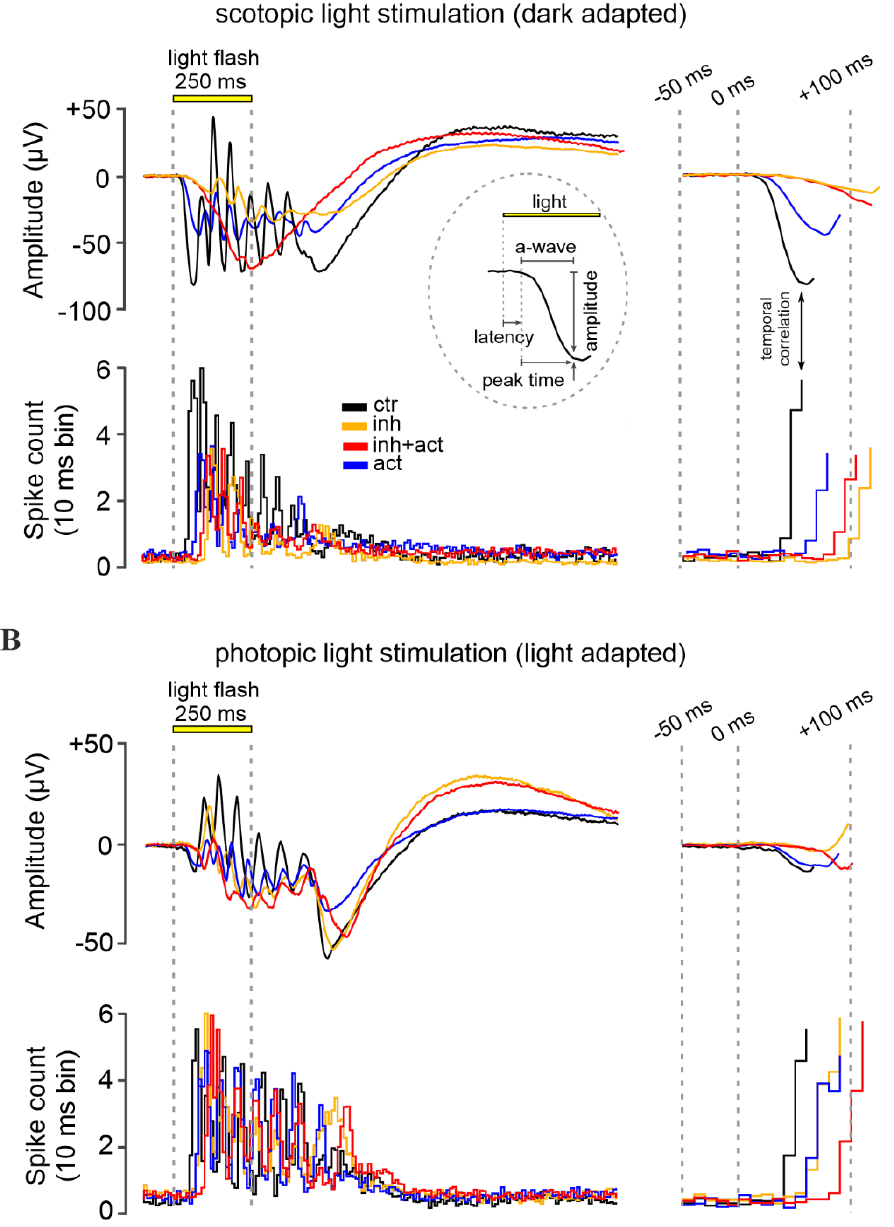
Figure 5. Effects of cGMP analogues on retinal function. Representative light-evoked dark-adapted scotopic (rod) ( A ) and light-adapted photopic (cone) ( B ) micro-electroretinogram ( µ ERG) of the mouse retina. Control recording (black) was compared to retina treated with the CNG-channel inhibitor Rp-8-Br-PET-cGMPS (50 µ M, orange), the CNG-channel activator 8-pCPT-cGMP (0.1 µ M, blue), or both compounds in combination (red). Displayed below the µ ERG traces is the correlated retinal ganglion cell spiking activity recorded by multi-electrode arrays (MEA). Data shown at maximum scotopic and photopic light intensity, respectively (see Figures S3 and S4 for µ ERG recordings at all light intensities). The left panel illustrates the recorded signals, while the right panel highlights the initial light-response features, magnified in time. The initial negative deflection of the µ ERG, the a-wave, represents the hyperpolarizing photoreceptor response. Subsequent oscillations reflect responses of inner retinal cells. The inset in ( A ) displays the a-wave evaluation parameters: latency, peak-time, and amplitude.